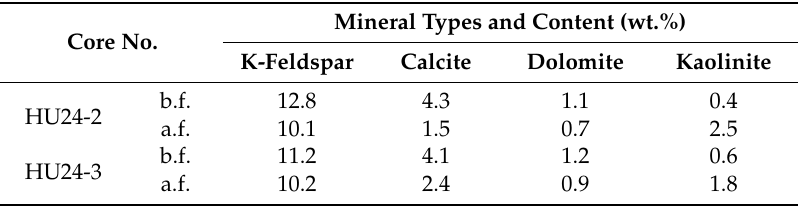
Table 9. Minerals with significant changes in contents after